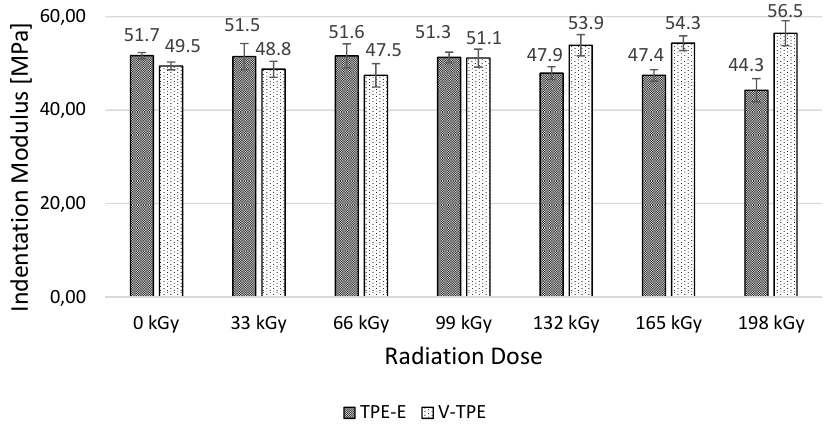
Figure 6. Micro-indentation modulus—TPE, V-TPE.